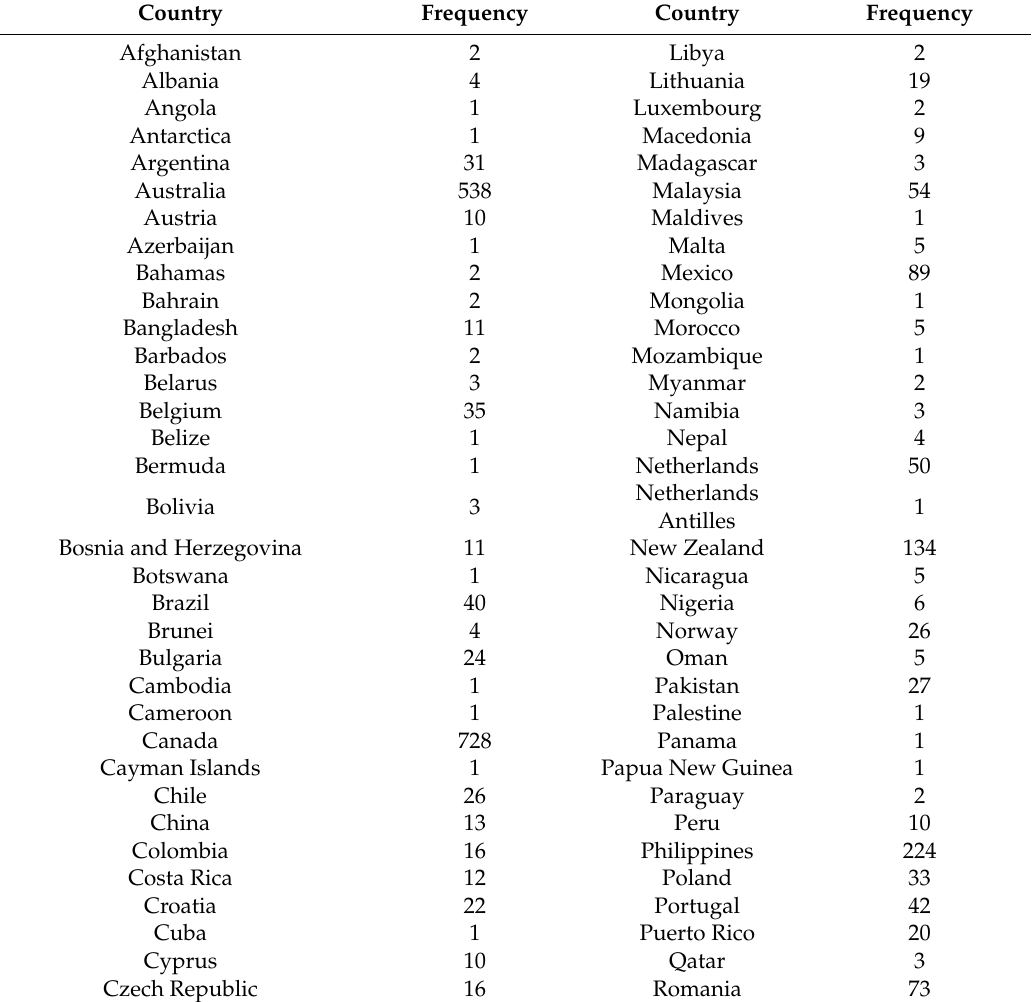
Table A1. Demographic count for participants by country ( n =